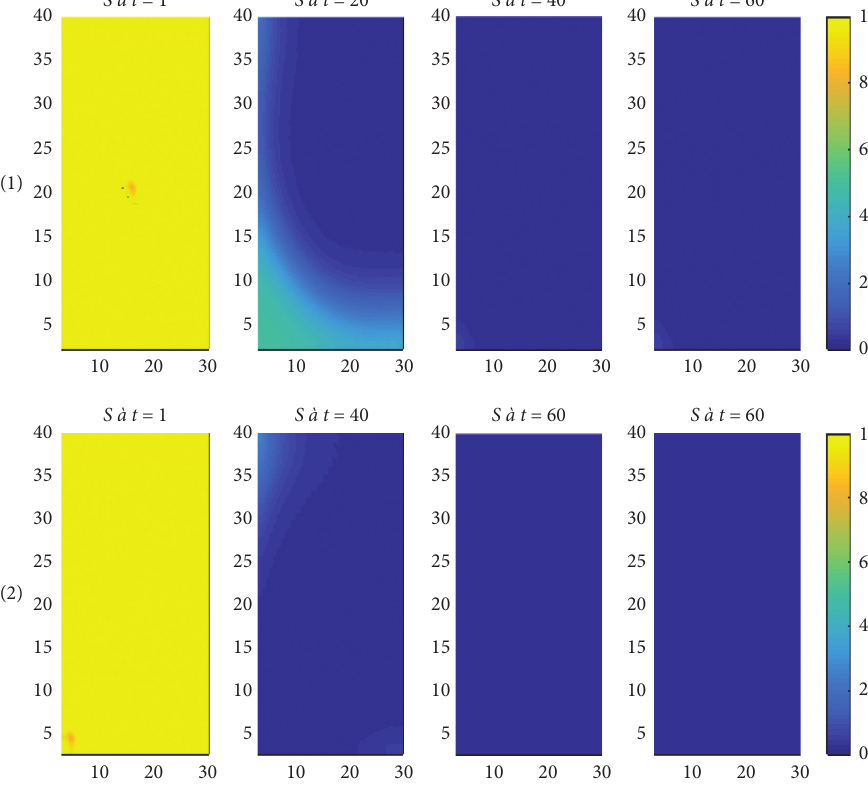
Figure 8: Susceptible behavior within Ω with control (vaccine strategy starts from the first